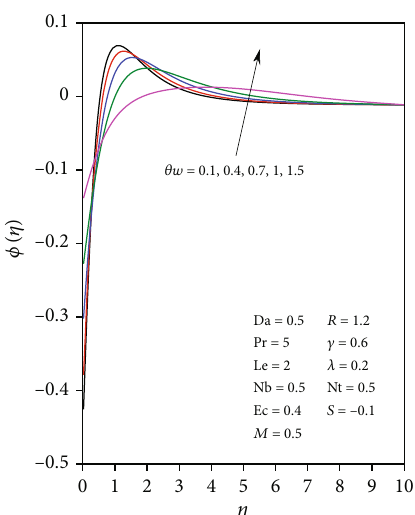
Figure 17: Concentration of nanoparticle pro fi le for di ff erent values of Pr .